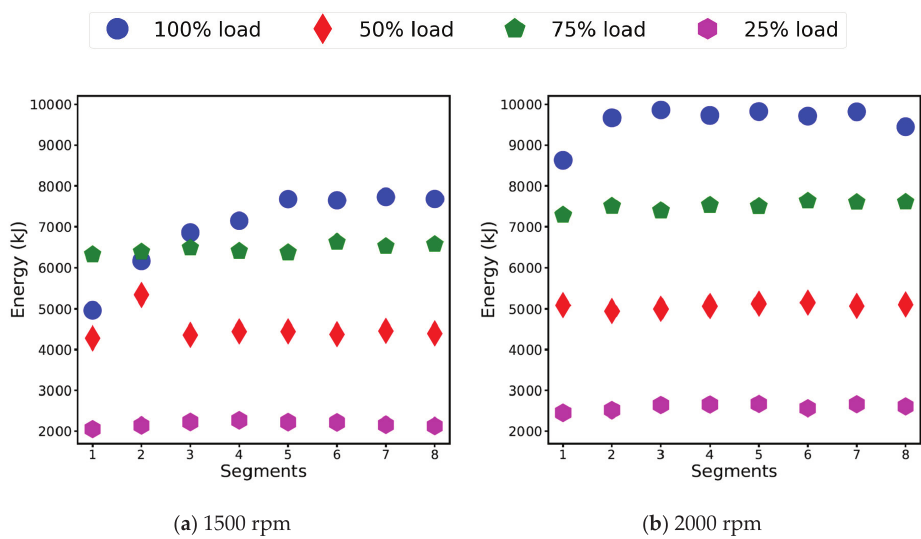
Figure 13. Cumulative energy released from combustion at each load in each segment at ( a ) 1500 and ( b ) 2000 rpm. The blue circle represents 100% load, the red diamond 50% load, the green pentagon 75% load and the pink hexagon 25% load.